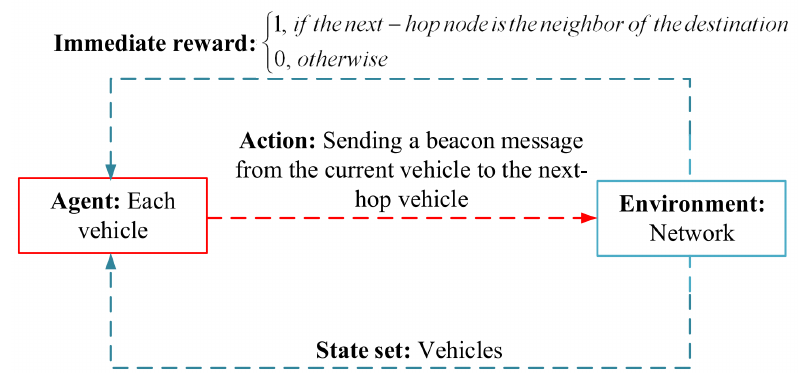
Figure 20. Learning structure in